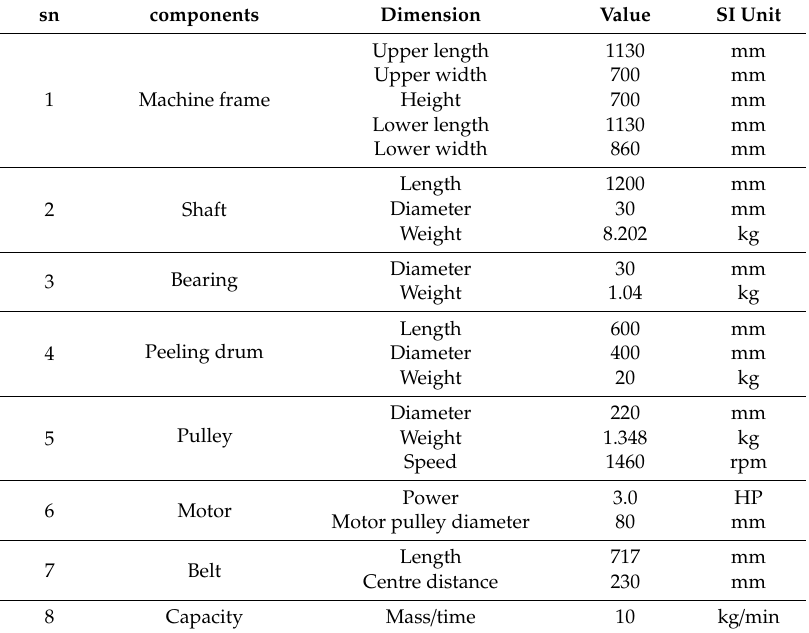
Table 3. Machine technical